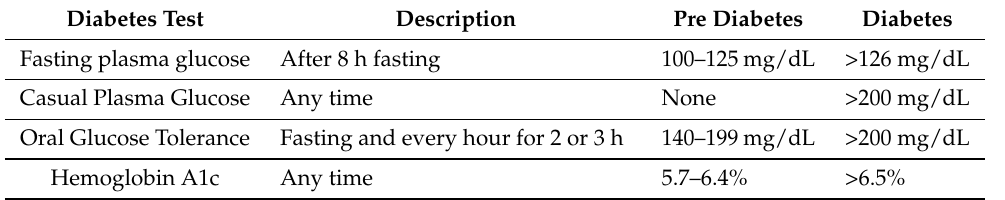
Table 1. Diabetes test values for diabetes and prediabetes. Diabetes Test Description Pre Diabetes Diabetes Fasting plasma glucose After 8 h